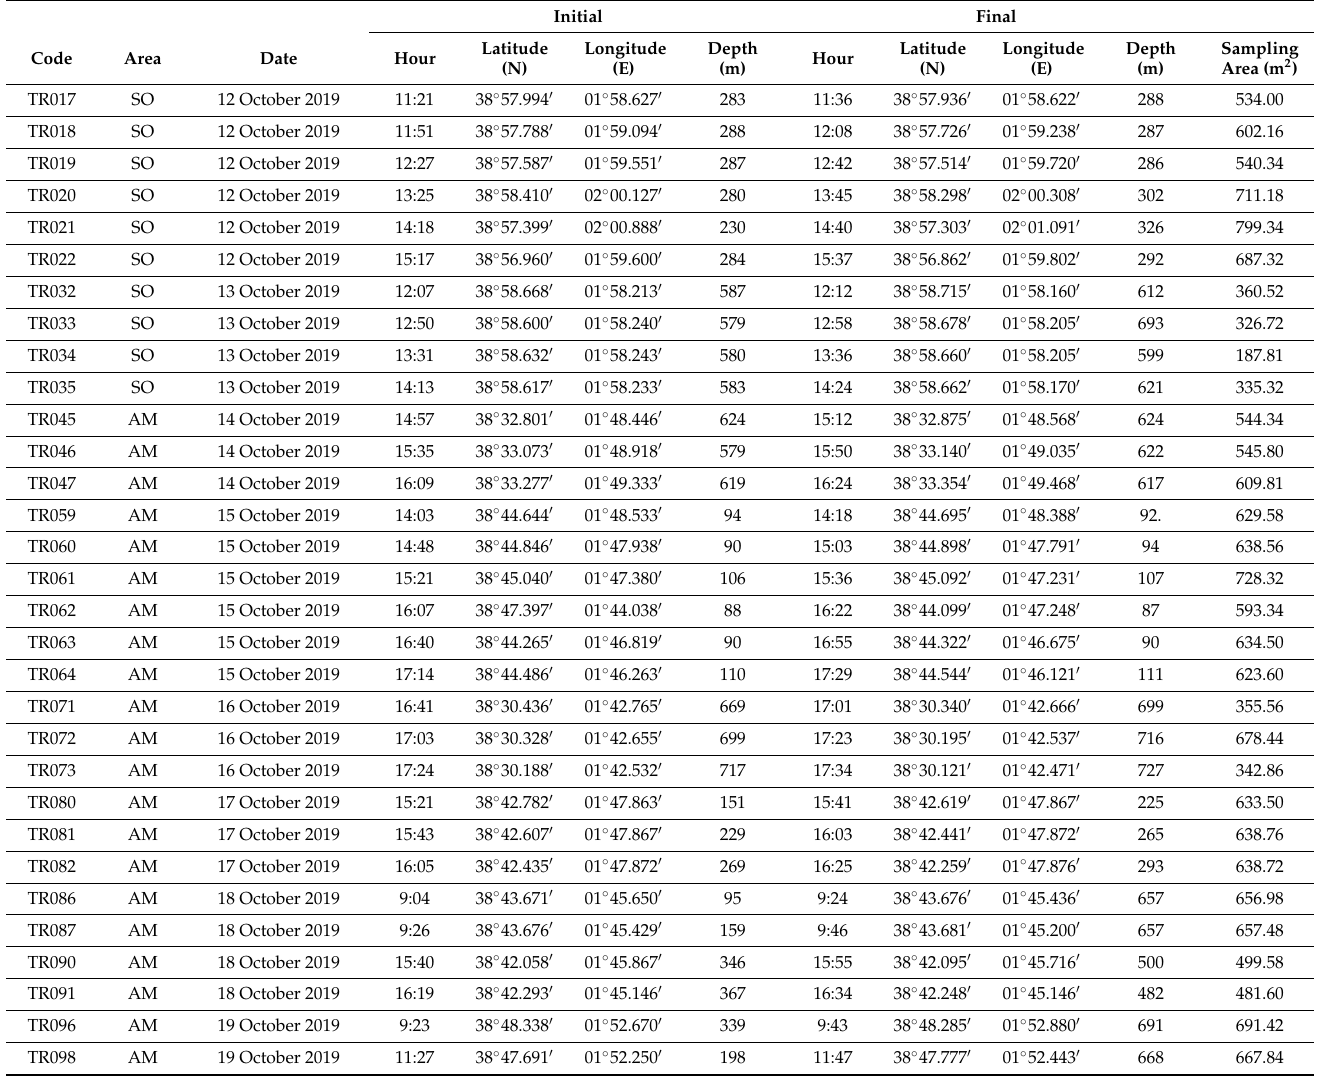
Table A5. Characteristics of the sampling stations carried out with the TASIFE photogrammetric sledge (ROTV) in the Mallorca Channel seamounts Ses Olives (SO), Ausias March (AM), and Emile Baudot (EB) during the INTEMARES